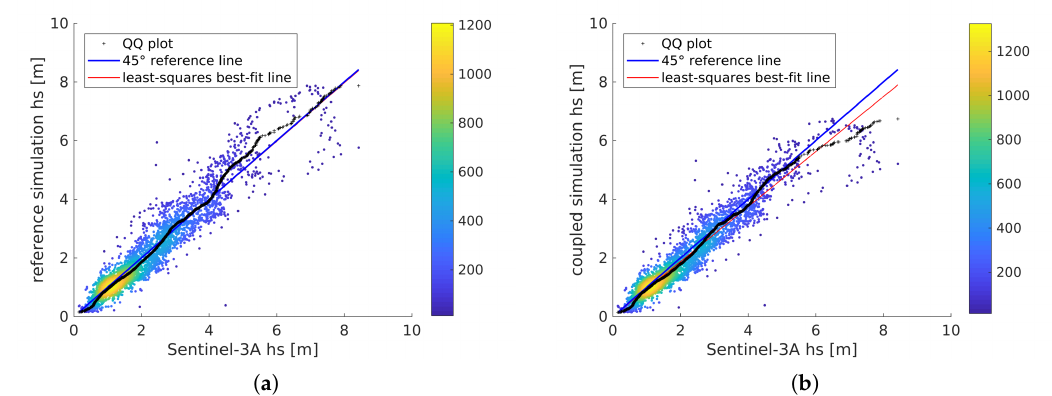
Figure 5. Q–Q scatter plots for the measured (Sentinel-3A) significant wave heights and modelled significant wave heights with the ( a ) reference and ( b ) coupled model simulations for January 2017. The Q–Q plot is shown as black crosses, the 45 ◦ reference line is denoted by the blue line, and the least-squares best-fit line is the red line.